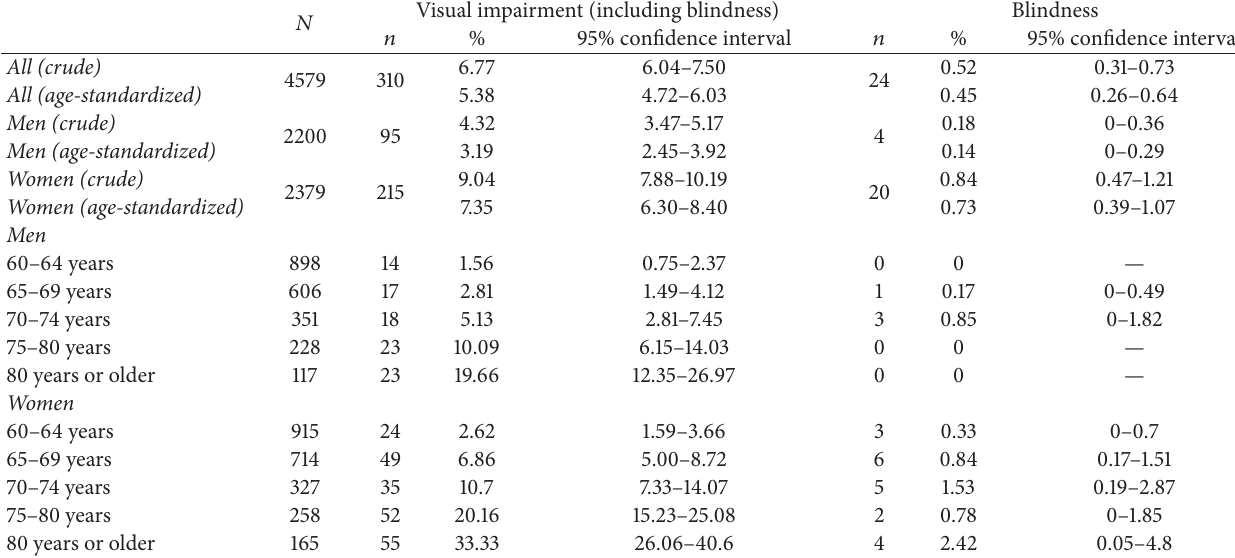
Table 1: Prevalence of visual impairment and blindness by age and gender.